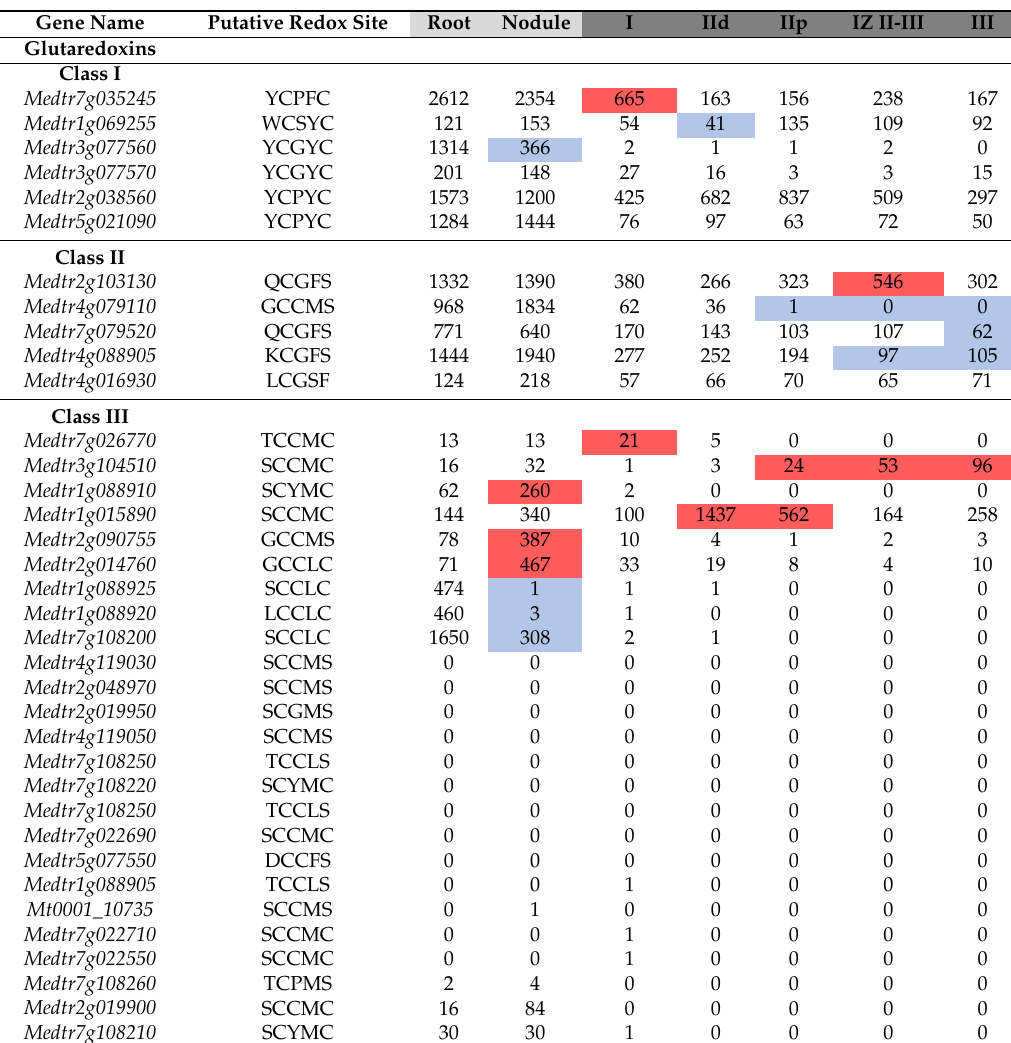
Table 2. Expression of glutaredoxins in M. truncatula nodules. Gene accession numbers are indicated in the table. Gene annotation is based on candidate orthologues and interprodomain signature. The different columns correspond to root and nodule whole organ analysis (Root and Nodule) and to the nodule zones: meristematic zone (I), distal infection zone (IId), proximal infection zone (IIp), infection/fixation interzone (IZ II-III) and nitrogen-fixation zone (III). The numbers in the different columns correspond to Total Reads ribominus. All RNA-seq read values were normalized [50]. The total reads are reported from the symbimics bioinformatics website. The full organs are nitrogen starved Roots and 10 days old nodules. The red and blue colours correspond respectively to higher and lower significant differences between the organs (roots and nodules) and between the different nodule zones. The statistical differences are reported from the symbimics bioinformatics